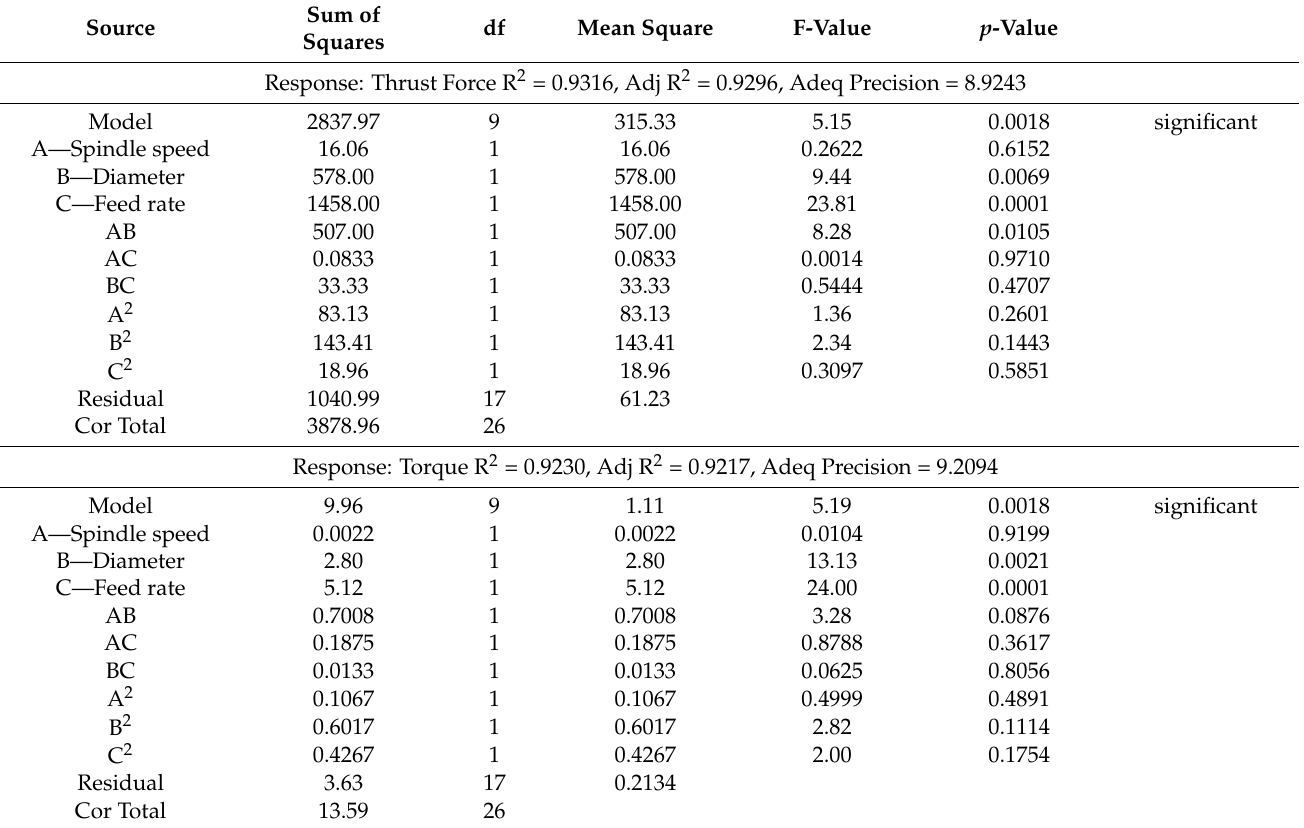
Table 5. ANOVA generated by the Design-Expert software for the response “Thrust Force” and